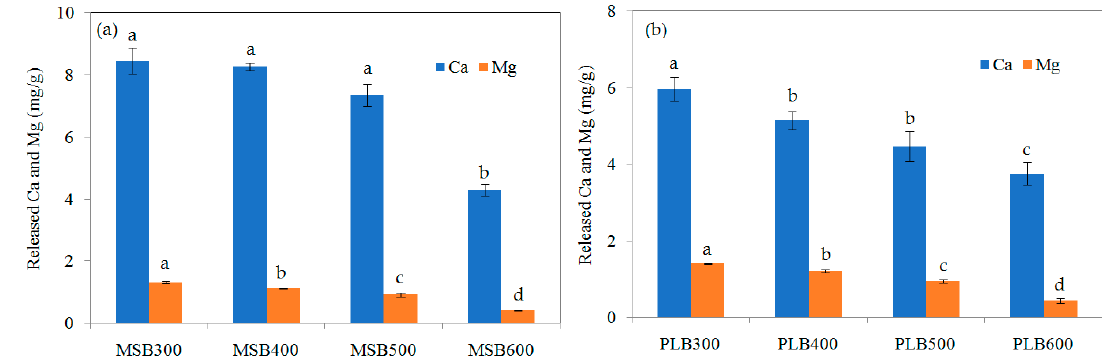
Figure 5. Water-soluble amounts of Ca 2+ and Mg 2+ for ( a ) MSB and ( b ) PLB pyrolyzed at 300, 400, 500 and 600 °C at pH 4.5–5.0. The bars marked by different letters indicate significant differences ( p < 0.05).